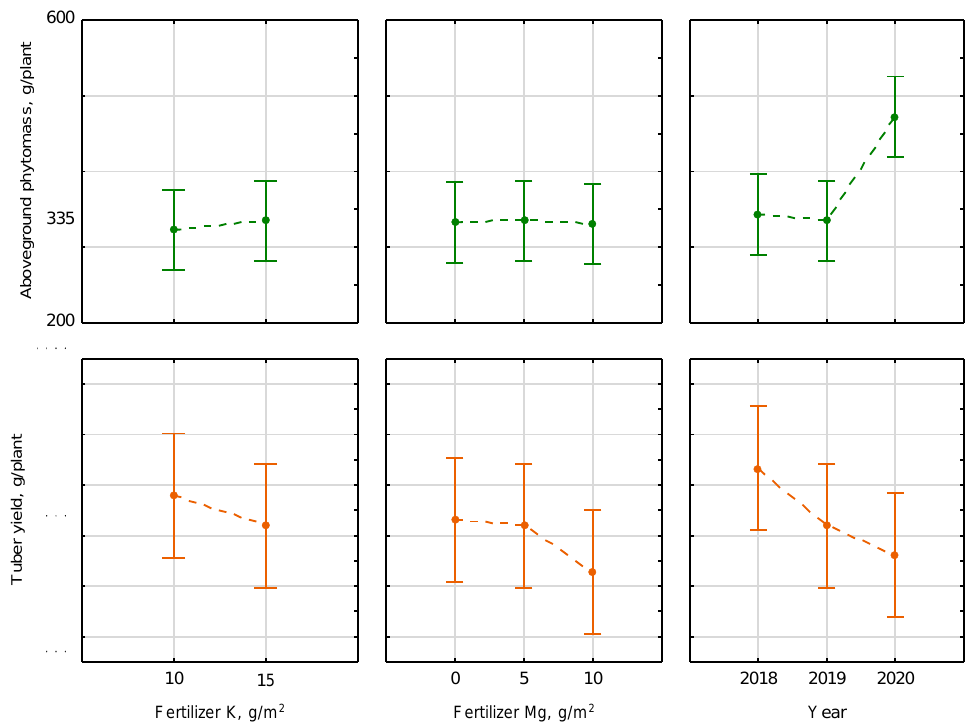
Figure 1. Profiles for predicted values of aboveground potato phytomass and tuber yield in the microplot field experiment in the south of West Siberia according to the GLM model (R 2 = 0.68 for the aboveground potato phytomass and R 2 = 0.30 for the tuber yield). Table 5. ANOVA results: factor contribution (%) to the total variance of potato aboveground phytomass and tubers in the microplot field experiment with potassium (FK) and magnesium fertilization